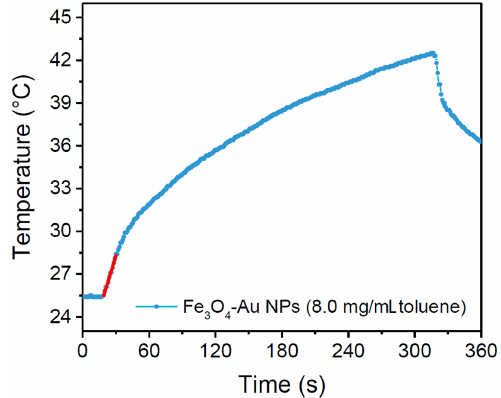
Figure 5. Temperature kinetics of a Fe 3 O 4 -Au NPs suspension in toluene (8.0 mg / mL) acquired applying for 300 s an alternating magnetic field of 17 kA / m amplitude (H 0 ) and 183 kHz frequency